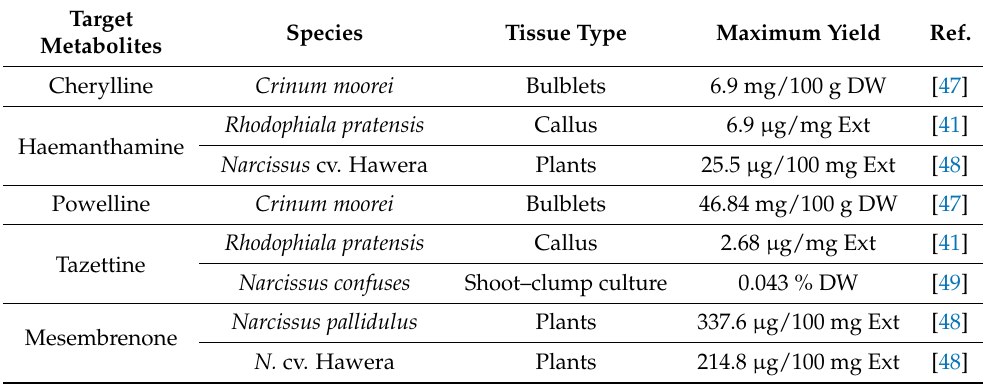
Table 1. Yields of uncommon AAs of therapeutical interest in in vitro